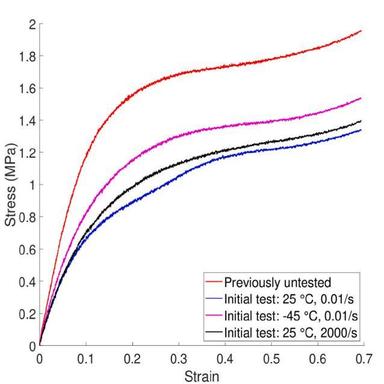
Comparing the residual strength responses of F-NR4 at 25 ◦C for samples which were previously compressed under various conditions.